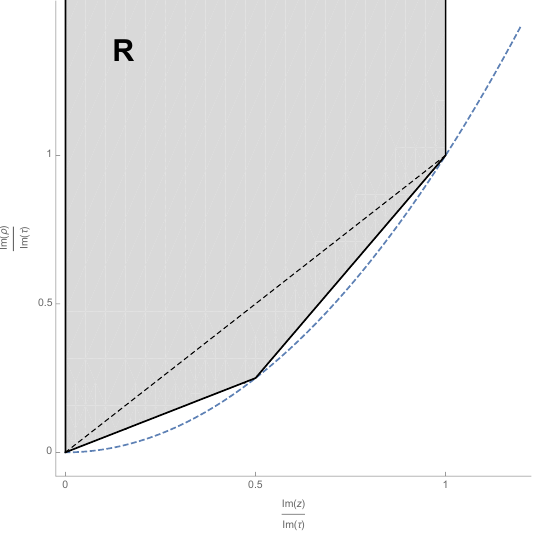
Figure 3 . Here we show the chamber R for the paramodular group (cid:0) + chamber for SP (4 ; Z ). The blue dashed line is the boundary of the Siegel upper half plane. The black dashed line shows a linear pole for t = 1 that is not a linear pole of the paramodular group (cid:0) + . The chamber R is the union of two chambers of SP (4 ; Z ), lying to the left and right of the 2 black dashed line.